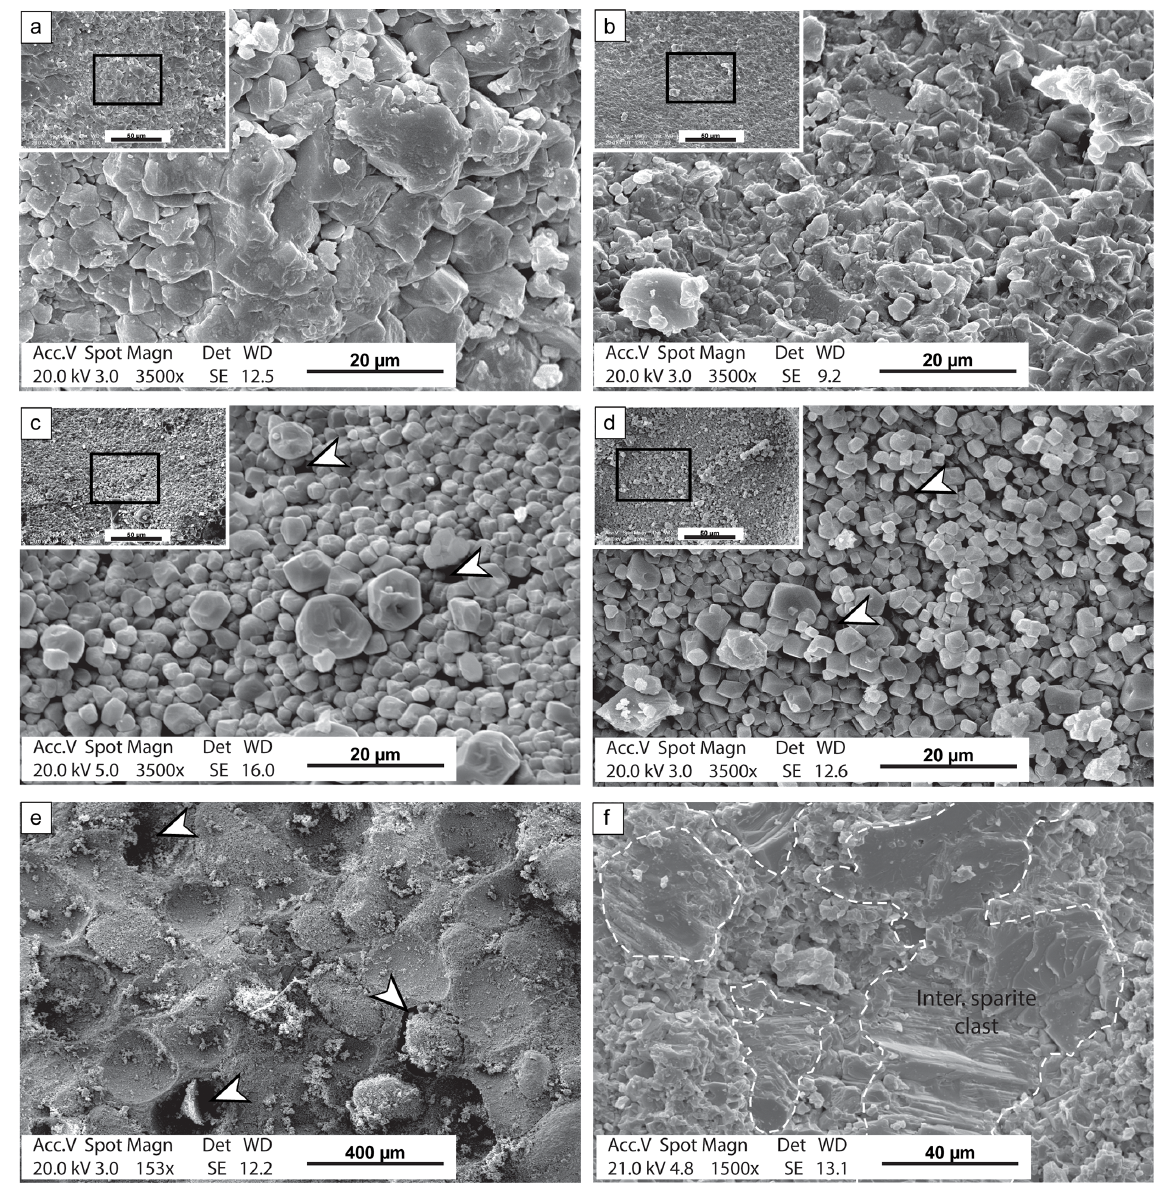
Figure 4. SEM pictures of micrite micro-fabric and microporosity (white arrows); (a) MF1 micrite micro-fabric in Castellas Fault zone (2.5m to fault plane); (b) MF1 micrite micro-fabric within D19 Fault zones (2m away from F5 fault plane); (c) MF3 micrite micro-fabric within Castellas host rock (188m away from the fault plane); (d) MF3 micrite micro-fabric within D19 host rock (95m away from F5 fault plane); (e) D19 host rock moldic porosity; (f) karst